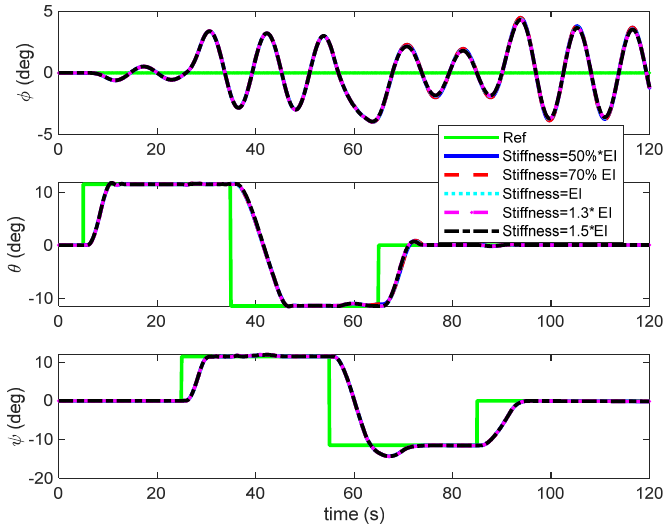
Figure 13. Attitude responses with five stiffness variants, winds and control faults.